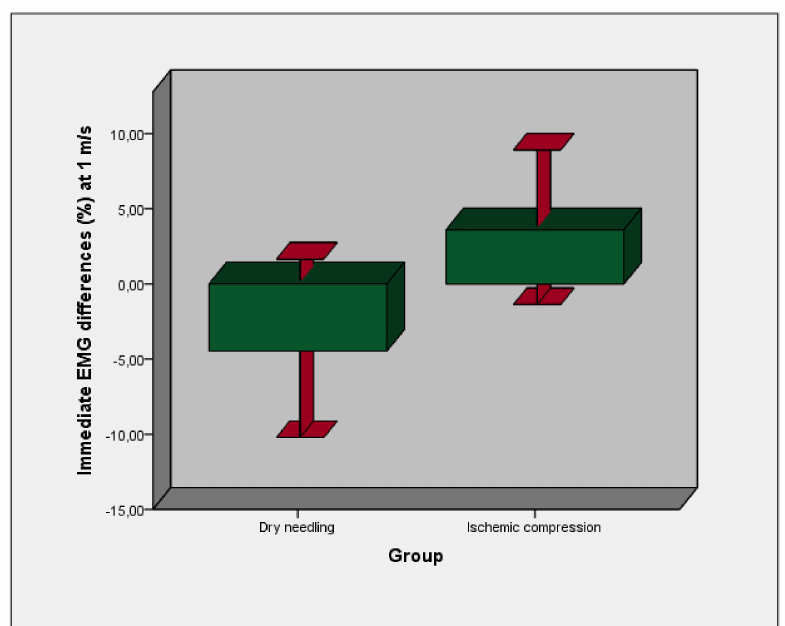
Figure 2. Bars graph with 95% confidence intervals (CI) error bars of immediate electromyograp- ic measurement differences after experimental (DDN) and control (ICT) interventions of muscle activity in medial or lateral gastrocnemius at a speed of 1 m/s